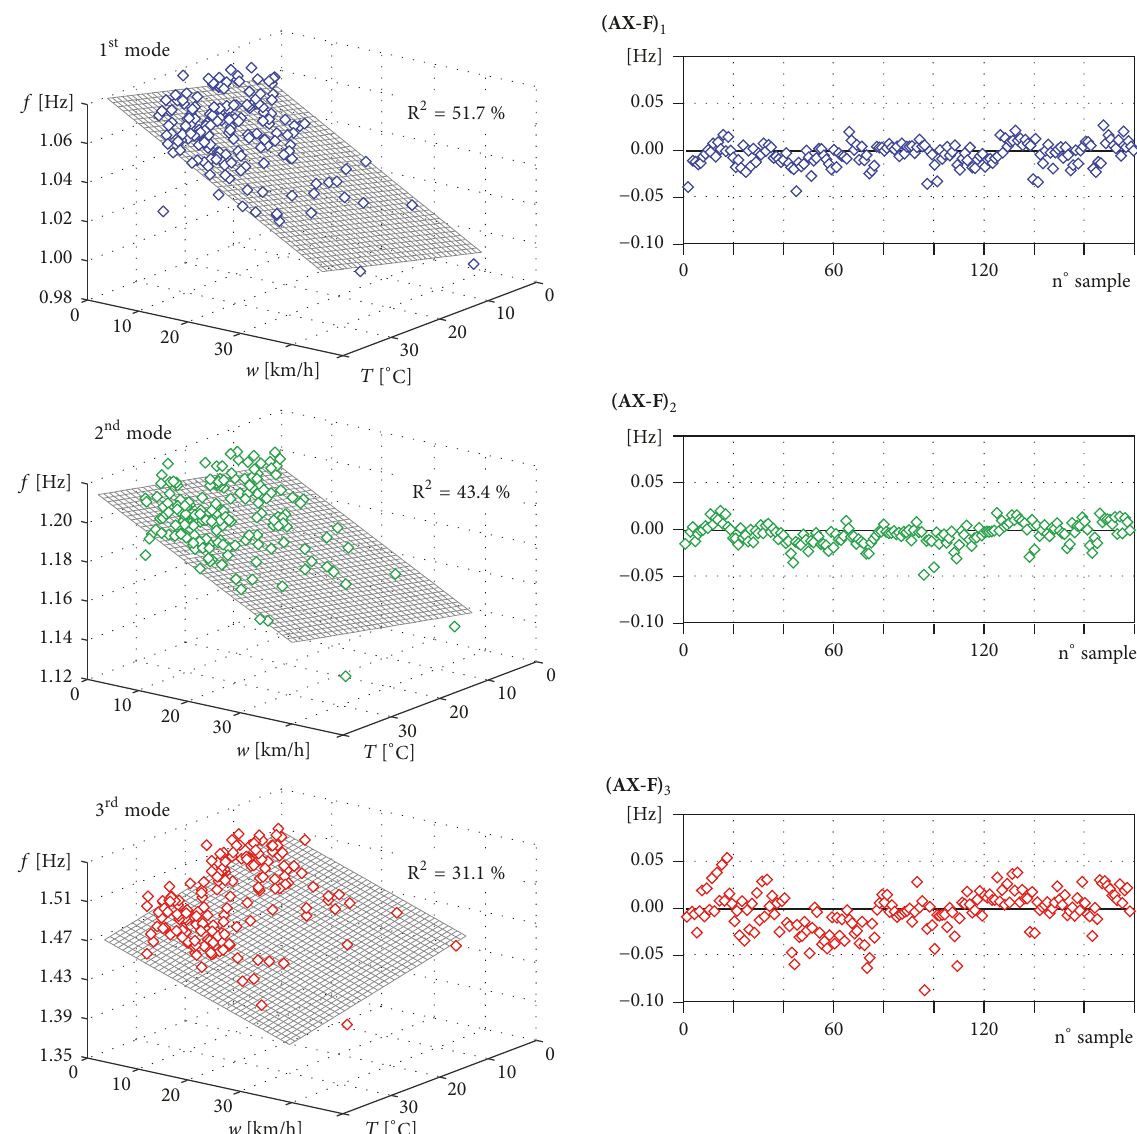
Figure 15: Multiple data regression of the first three fundamental frequencies and